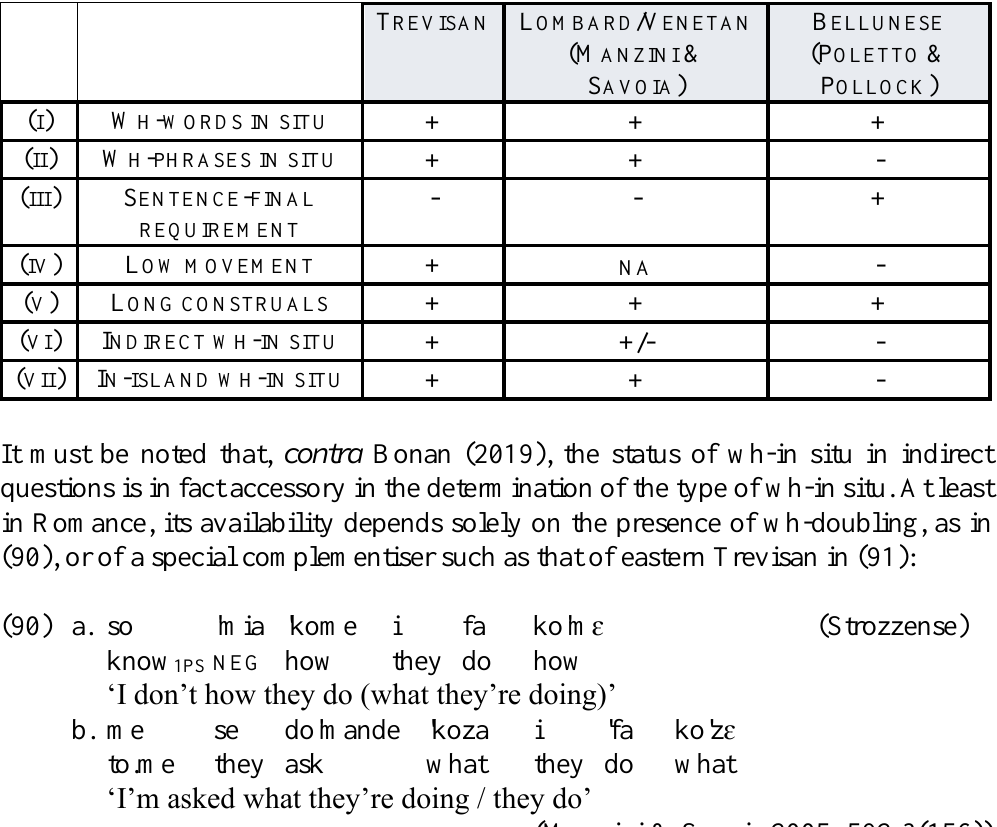
Table 1. Distribution of wh-in situ in NID